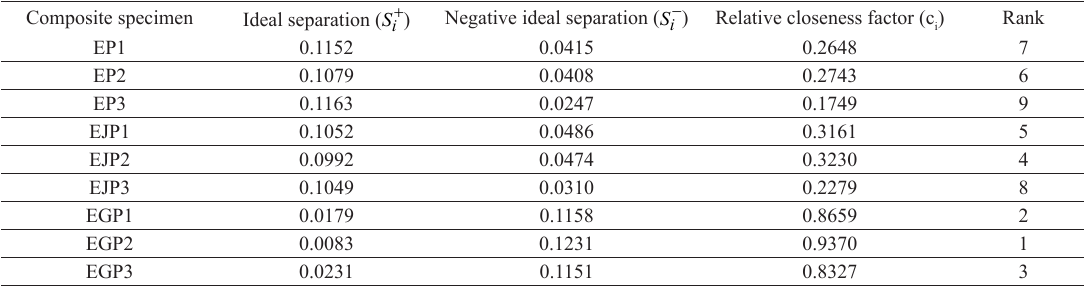
Table 6. Separation measure, relative closeness factor, and ranking of composites. Composite specimen